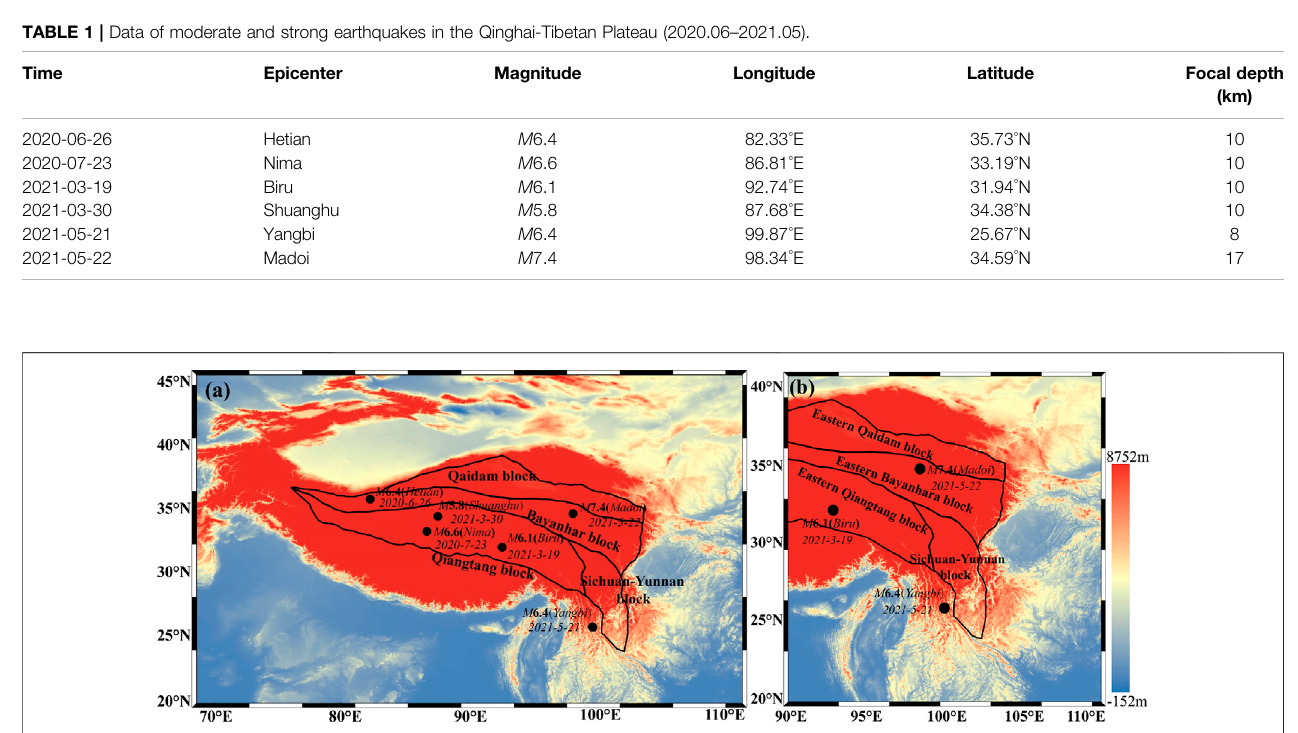
Frontiers in Earth Science |